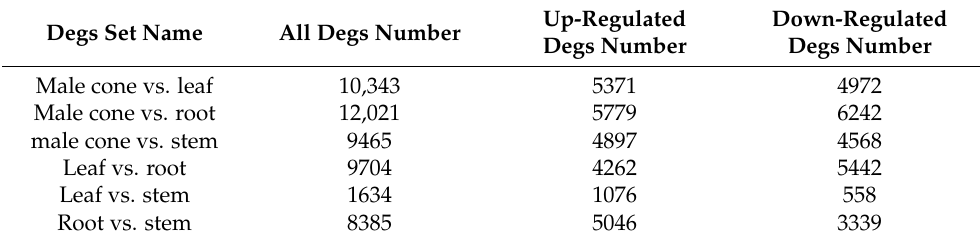
Table 3. The number of differentially expressed genes of tissues compared in